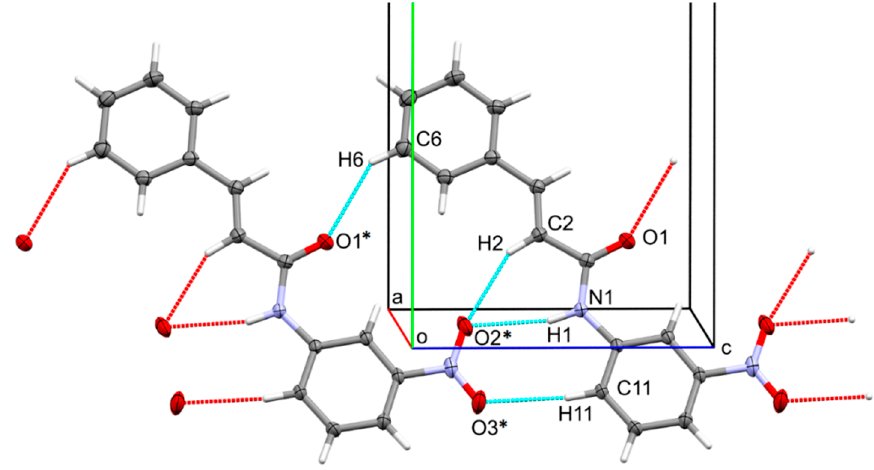
Figure 3. N–H ··· O and C–H ··· O interactions in Compound 1 , showing a segment of the ribbon of molecules along the c-axis direction. Labels included only for atoms involved in N–H ··· O and C–H ··· O interactions (symmetry operator *: x, y, z − 1).